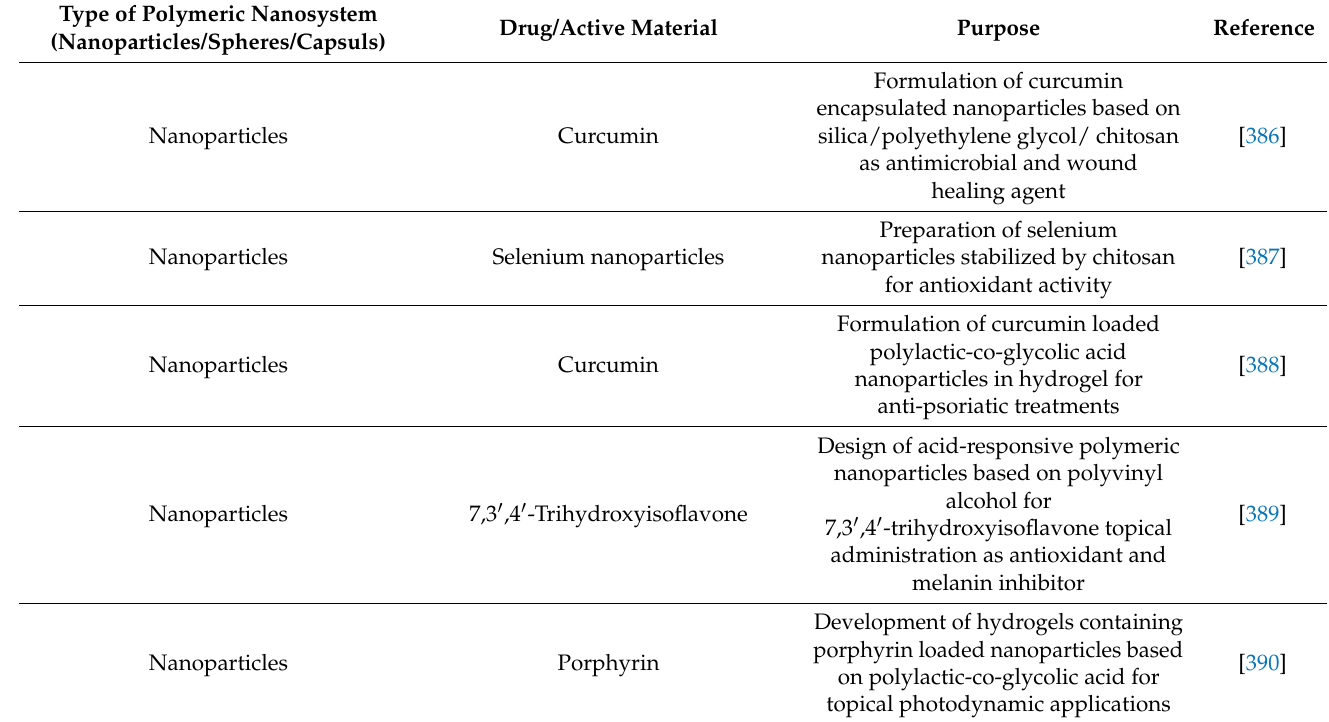
Table 4. Recent studies on dermal drug delivery systems comprising polymeric nanocapsules/ nanospheres/ microspheres. Type of Polymeric Nanosystem